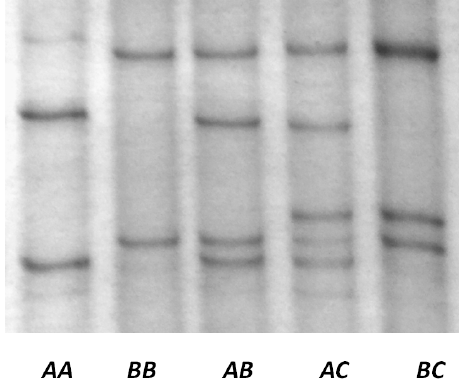
Figure 3. PCR–single-stranded conformational polymorphism (PCR–SSCP) of the ovine KAP22-1 gene. Table 1. SNPs and alleles of the ovine KRTAP22-1 .